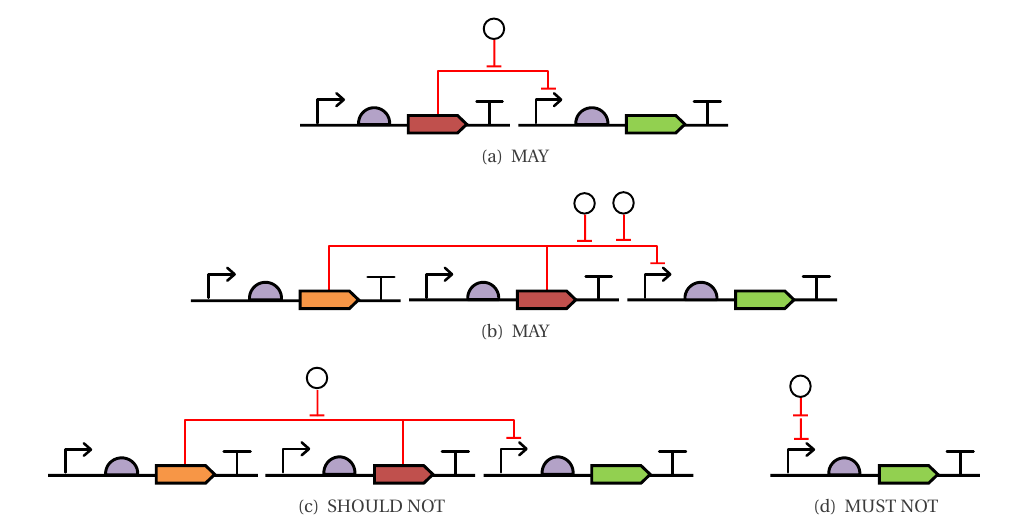
Figure 22: Examples of allowed and forbidden use of interactions with interactions: (a) aTc inhibiting repression by TetR. (b) Multiple inhibitions of an interaction with two tails. (c) Interactions SHOULD NOT connect to only one head of a multi-head or tail of a multi-tail interaction. (d) interactions MUST NOT connect to the head or tail of another